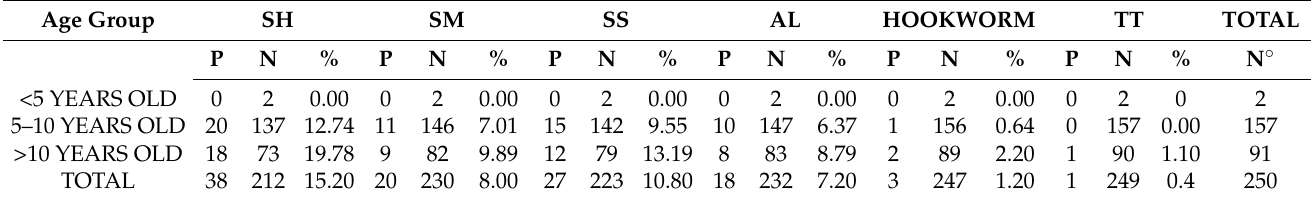
Table 3. Urogenital and intestinal infections classified by age